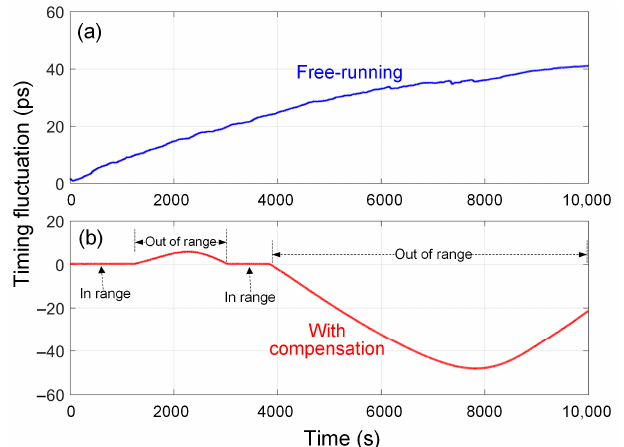
Figure 2. Timing fluctuation results for RF transfers with and without optical phase compensation. ( a ) Free-running link without compensation. ( b ) The link with